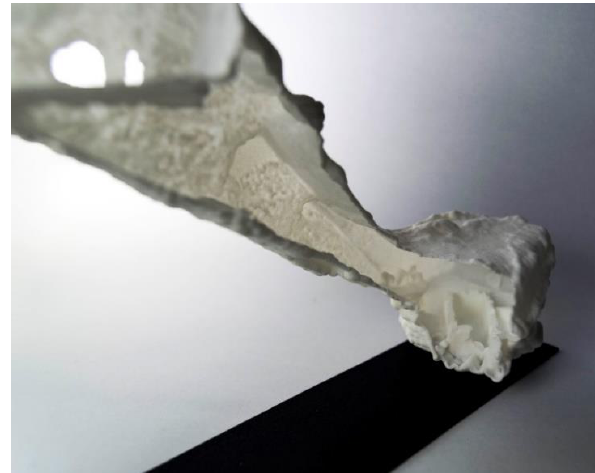
Figure 15: Model of the tomb of Ipi. General view.